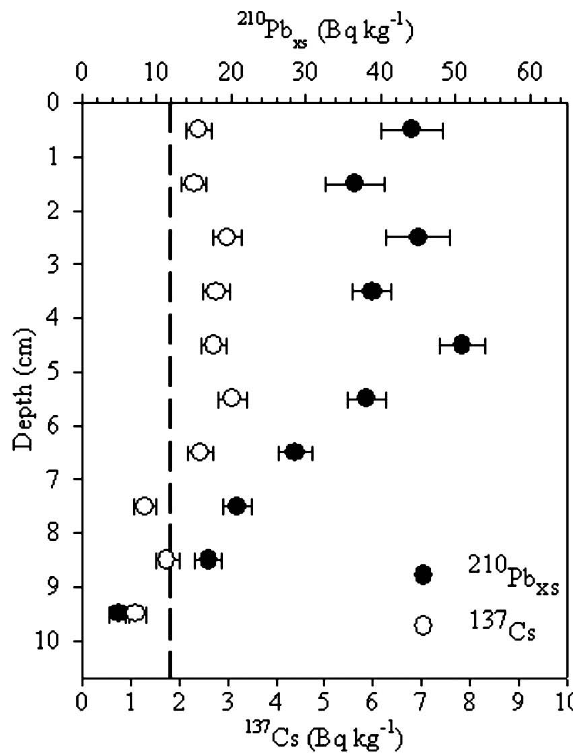
Fig . 5. – 210 Pb (filled circles) and 137 Cs (open circles) activities in xs core BC4 from the outer Bay of Cádiz. Dashed line indicates aver- age supported 210 Pb (= 226 Ra).